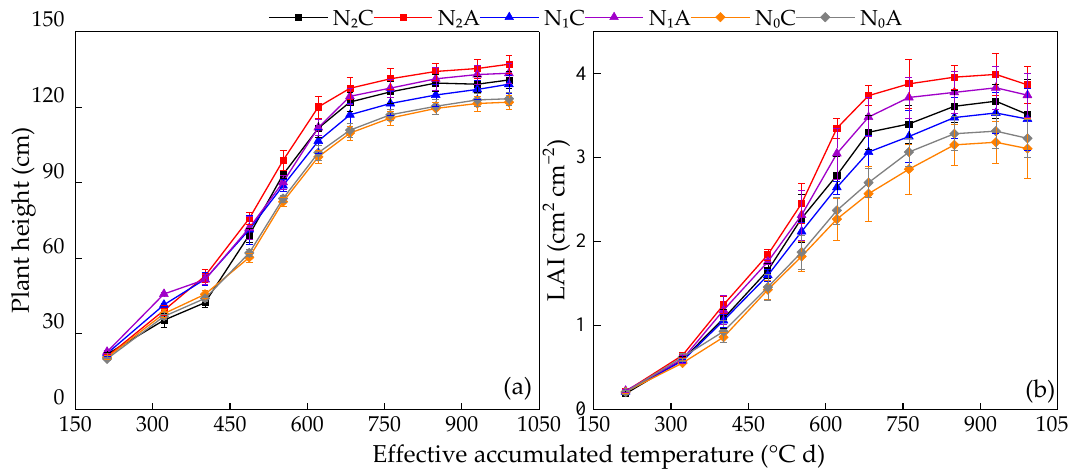
Figure 3. Dynamic changes in tomato plant height ( a ) and LAI ( b ) with effective accumulated temperature under different treatments.